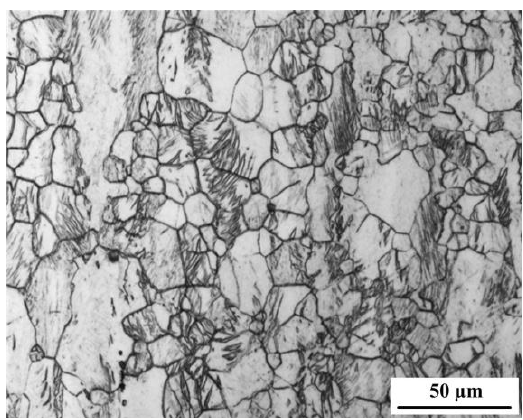
Figure 1. The microstructure of AZ31B magnesium alloy.